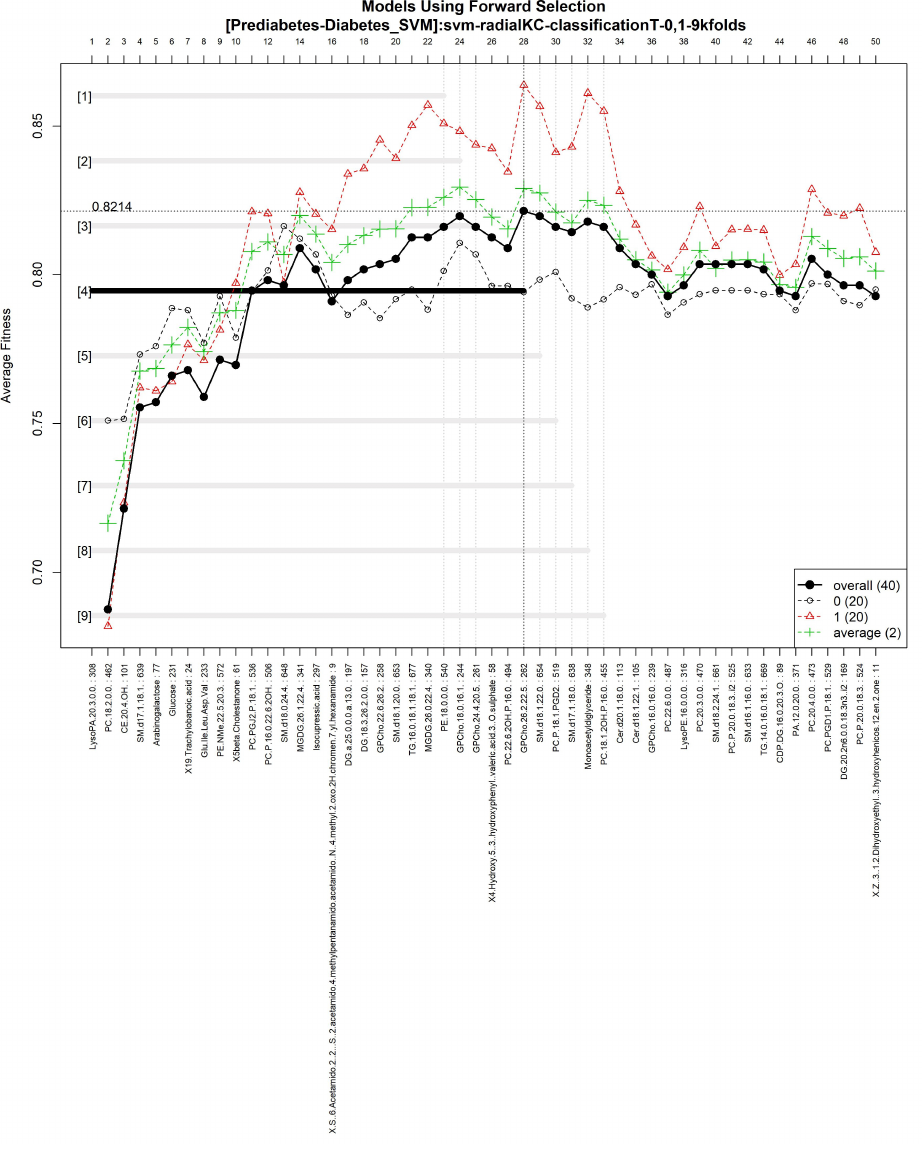
Figure 8. Models using forward selection methodology, with the Prediabetes-T2DM dataset. The solid black line represents the most compact and accurate model. The vertical axis shows the classification accuracy. The horizontal axis represents ordered features, each of which corresponds to a number. Table 8. Features obtained by the GALGO SVM method in the Prediabetes-T2DM